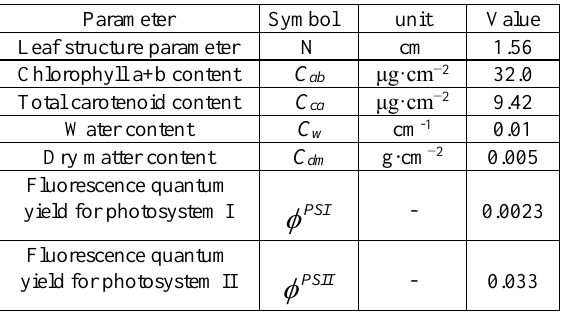
Table 2. The input parameters for Fluspect model